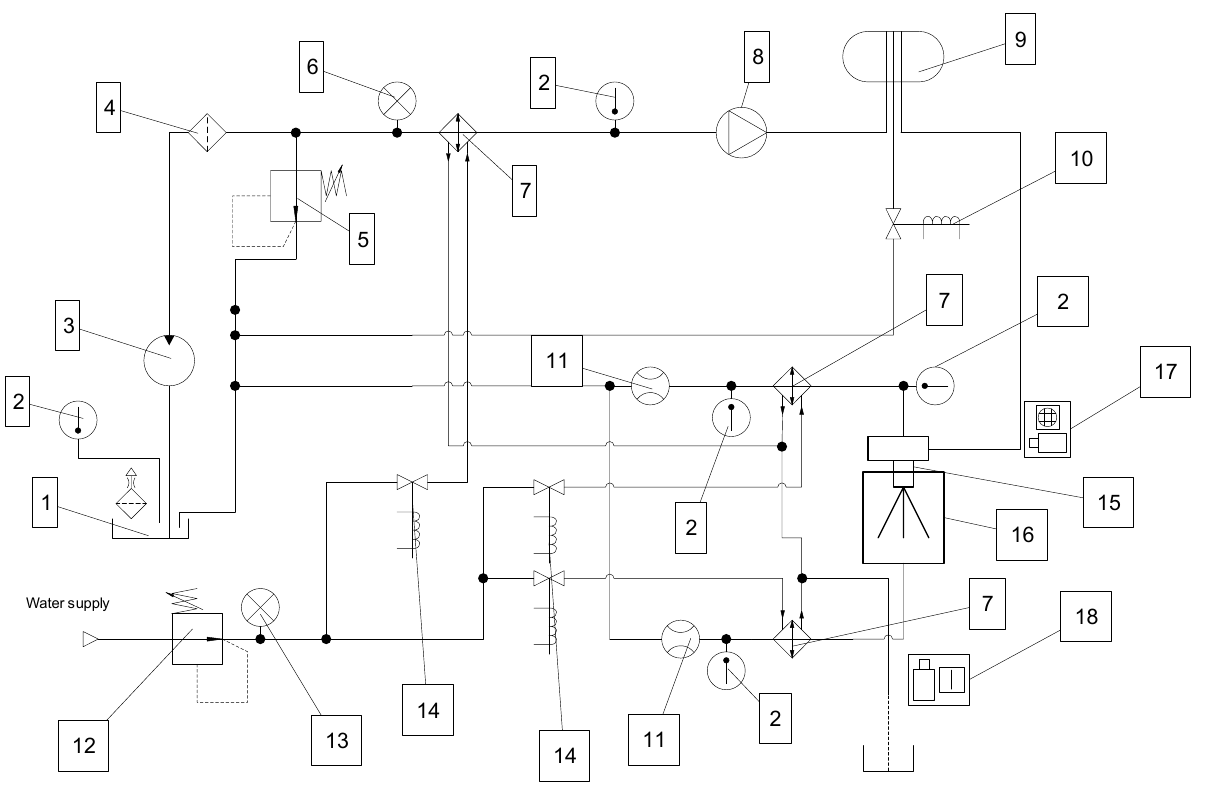
Figure 3. Schematic representation of the visualisation test station: 1—fuel tank with level sensor,